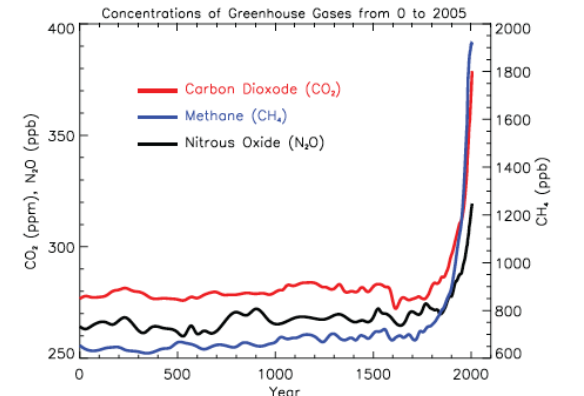
Figure 3. Atmospheric concentrations of the most important GHGs over the last 2,000 years. Increases since about 1750 are attributed to human activities in the industrial era. Concentration units are parts per million (ppm) or parts per billion (ppb) (from Forster et al., 2007). Present GHG concentrations (2017) are: CO 2 = 406 ppm, CH 4 = 1859 ppb, N 2 O = 330 ppb (WMO,